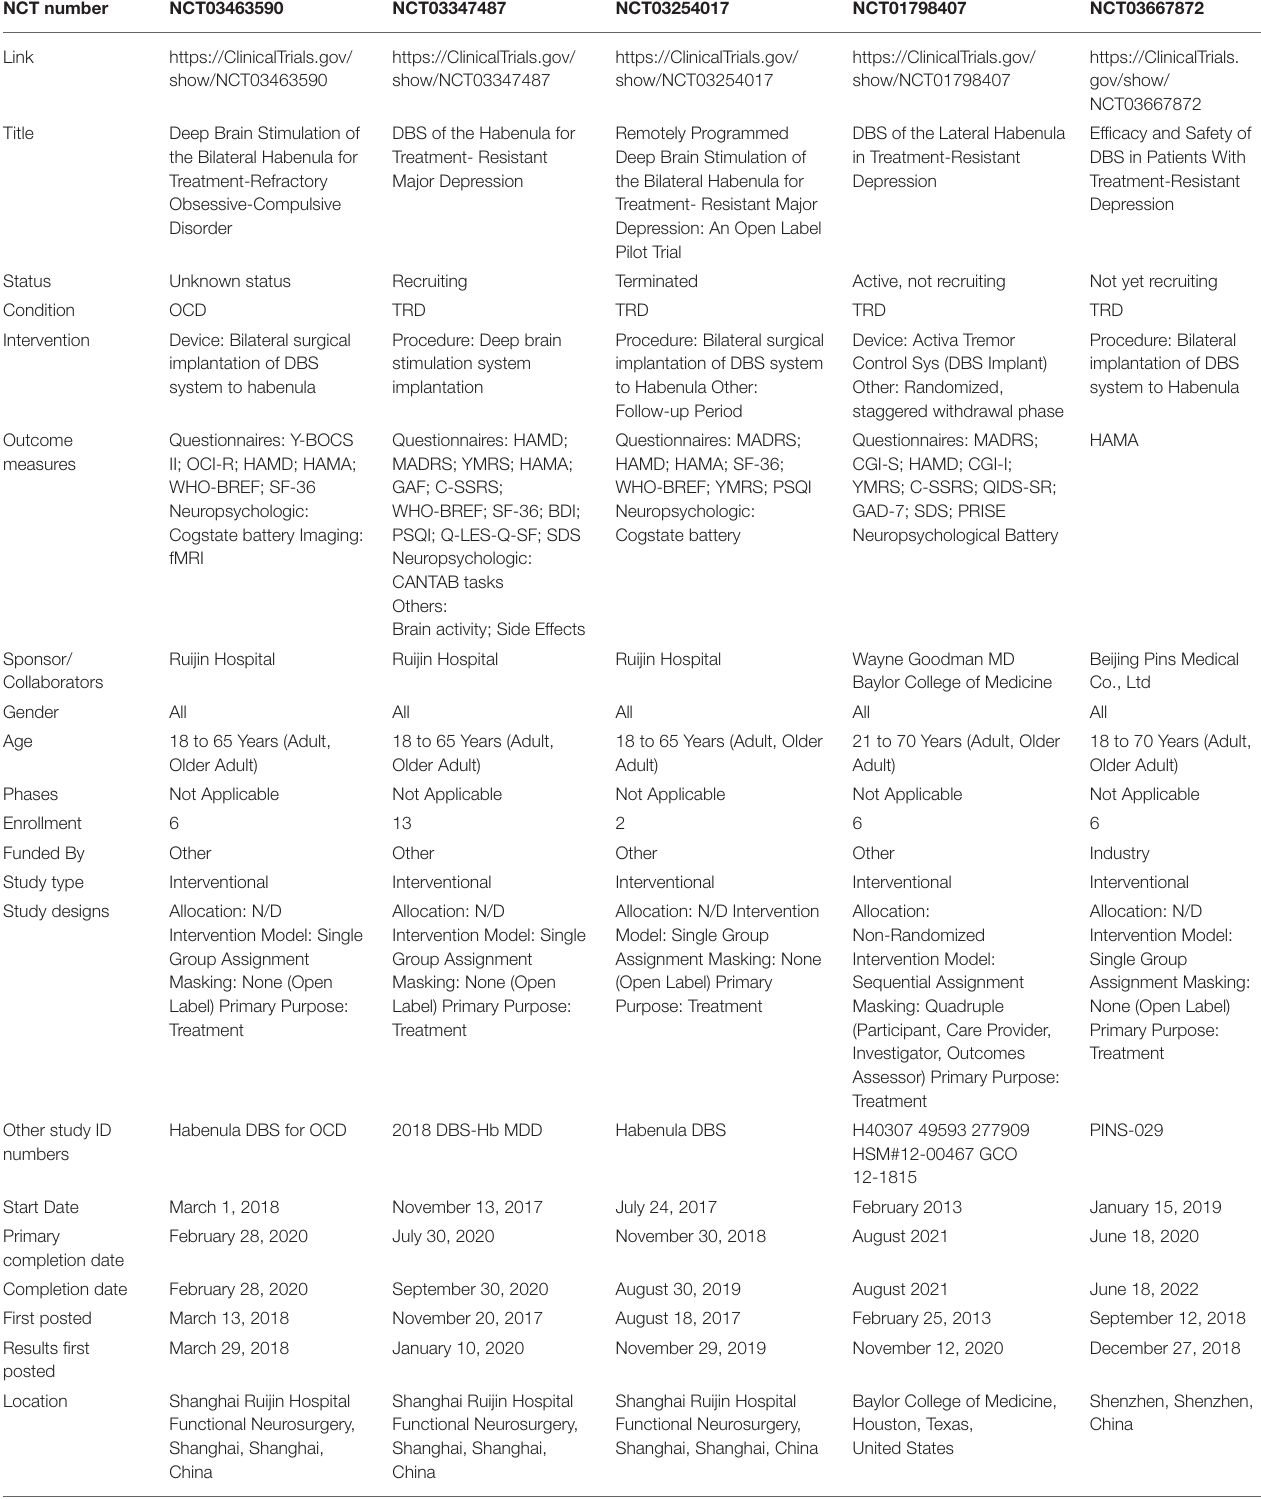
TABLE 4 | Registered clinical trials of habenula